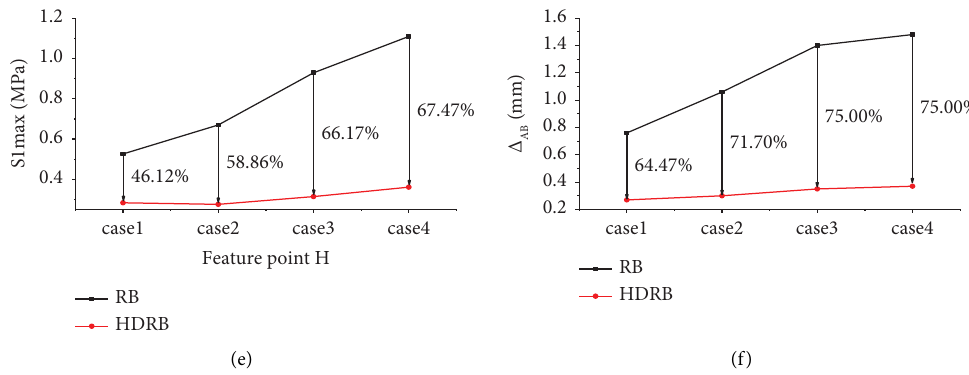
Figure 10: Seismic response maximum of aqueduct under diferent cases. (a) Maximum of the frst principal stress at point A. (b) Maximum of the frst principal stress at point B. (c) Maximum of the frst principal stress at point E. (d) Maximum of the frst principal stress at point F. (e) Maximum of the frst principal stress at point H. (f) Lateral relative displacement between feature point A and feature point